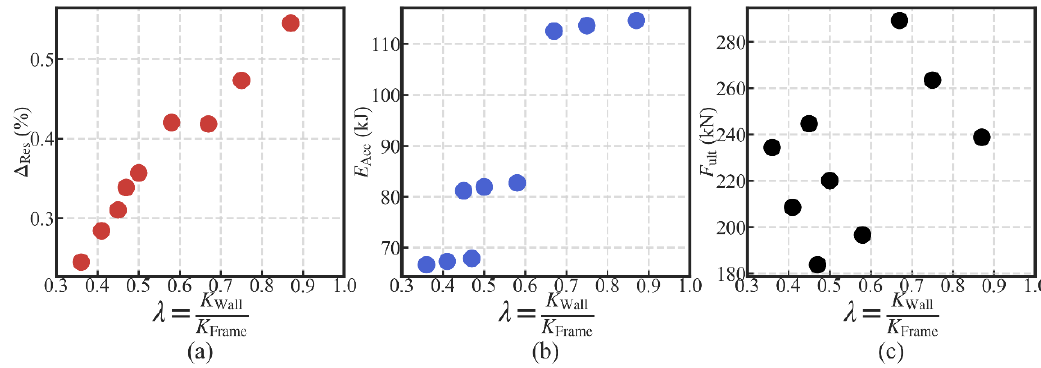
Figure 19. Influences of the lateral wall-to-frame stiffness ratio on: ( a ) self-centering performance; ( b ) energy dissipation performance; ( c ) ultimate strength.